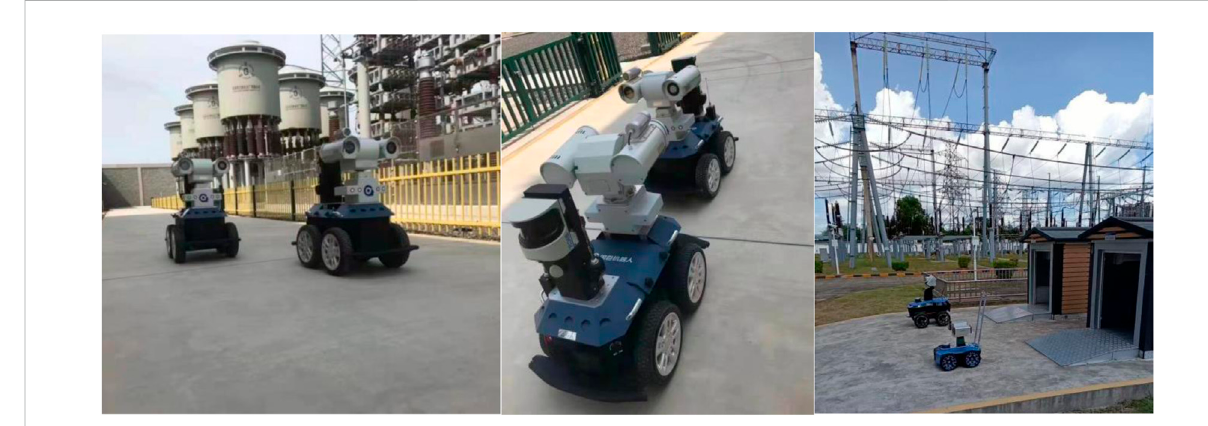
FIGURE 1 Video robotics in real-world grid applications.